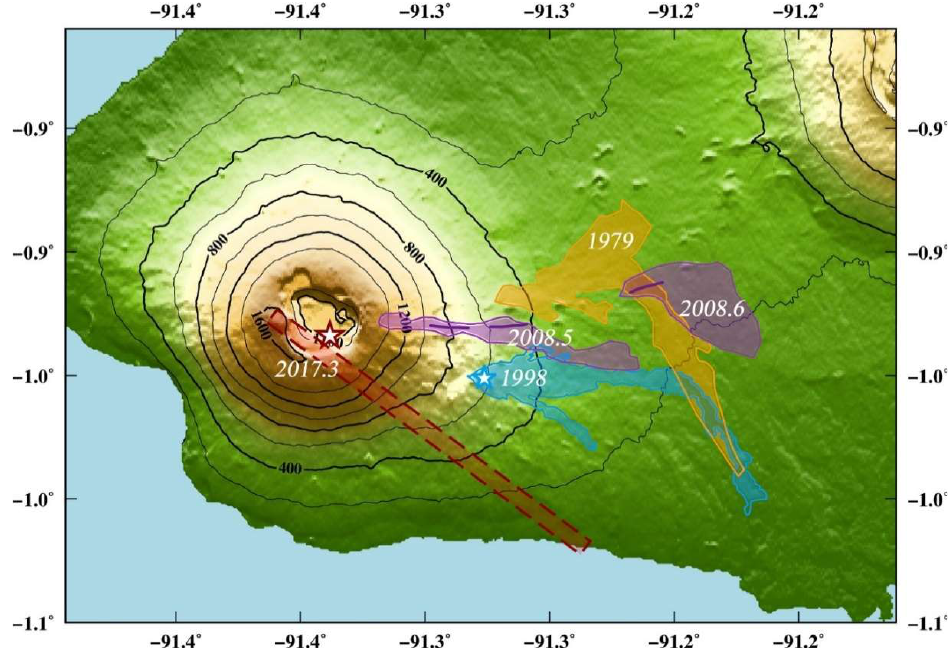
Figure 6. Lava lakes produced by Cerro Azul in 1979, 1998 and 2008 events. The red pentagram and dashed rectangle represent the underground magma sources projected on the surface for the March 2017 unrest event in interferogram IV. Purple areas mark the two lava flow areas from May to June 2008, deep purple curves represent the locations of magma rifts for these two eruptions [49], the blue area marks the lava lake basin erupted from September to October 1998, the blue pentagram marks the approximate location of the presumed magma rift [31,75], and the yellow area represents the presumed lava flows from the eruption event in 1979 [31,76].